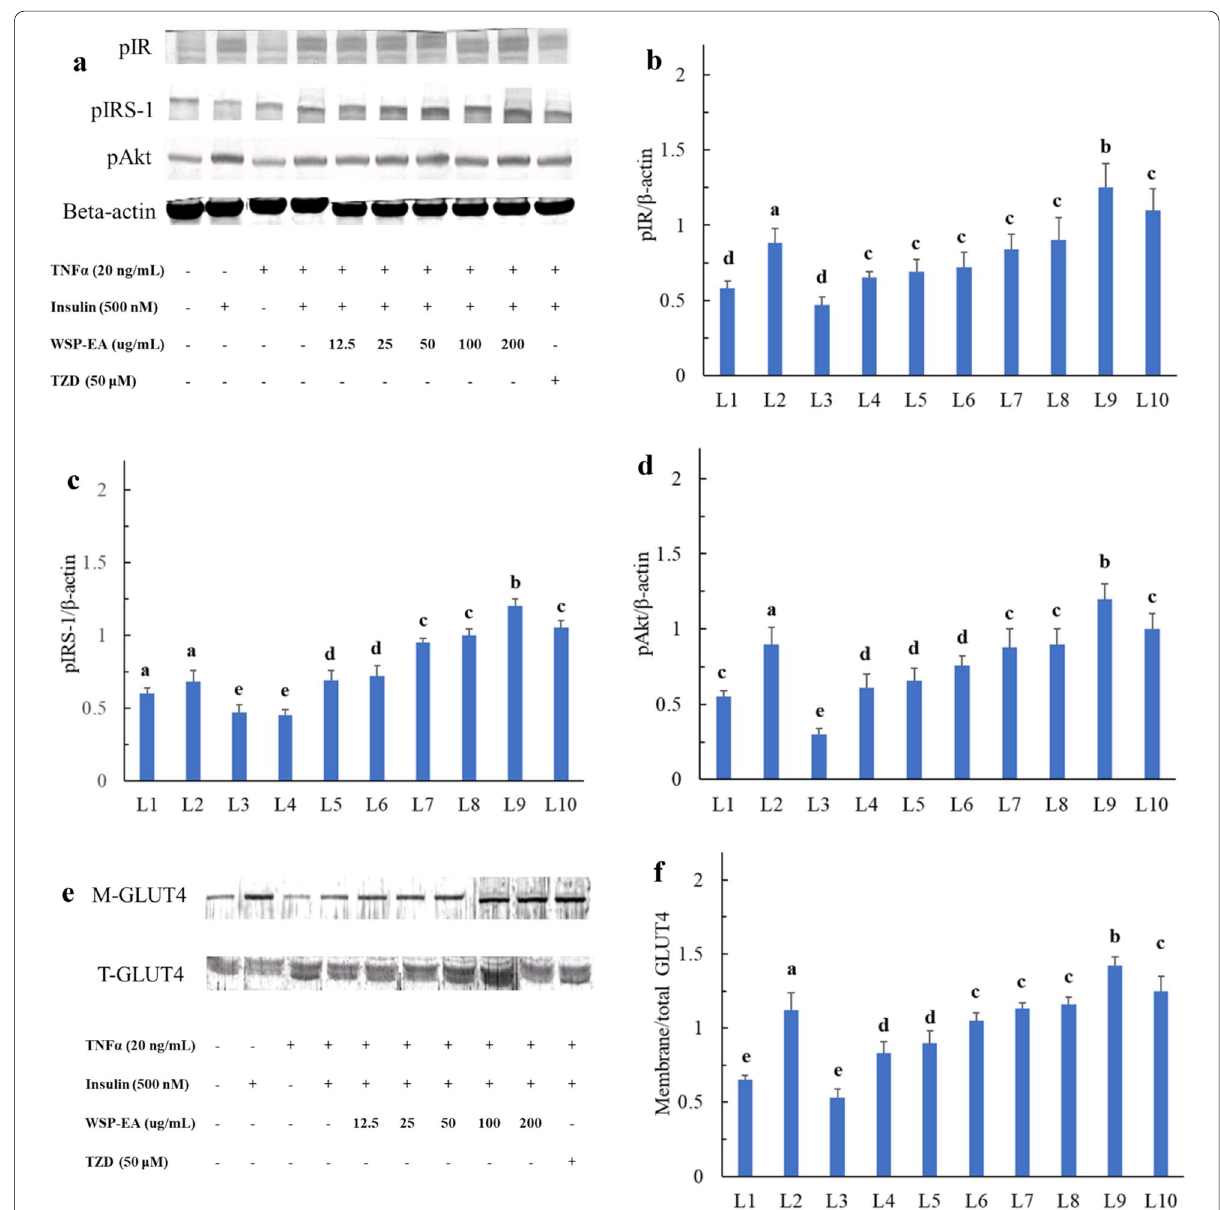
Fig. 5 Effect of WSP‑EA extracts on insulin‑stimulated phosphorylation of the PI3K/Akt pathway. A – F Western blotting of insulin‑stimulated phosphorylation of pIR, pIRS‑1, pAkt and M‑GLUT4 expression. TNF-α tumor necrosis factor alpha, ins insulin, WSP-EA white sweet potato ethyl‑acetate fraction. TZD thiazolidinedione, pIR phosphorylation of insulin receptor, pIRS-1 phosphorylation of insulin receptor substrate 1, pAkt phosphorylation of protein kinase B, describe the scale of y‑axis of each quantification: membrance glucose tranporter 4, T-GLUT4 total glucose transporter 4. Values were presented as mean SD as independent experiments performed in triplicate, and were analyzed using ± one‑way ANOVA, followed by a post hoc Tukey’s test for multiple comparisons. The scale of y‑axis of each quantification means ratio of candidate phosphorylated‑protein expression to house keeping protein ( B – D ) or ratio of M‑GLUT4 to total GLUT4. Different letters above the error bars indicate significant differences among treatments ( P <